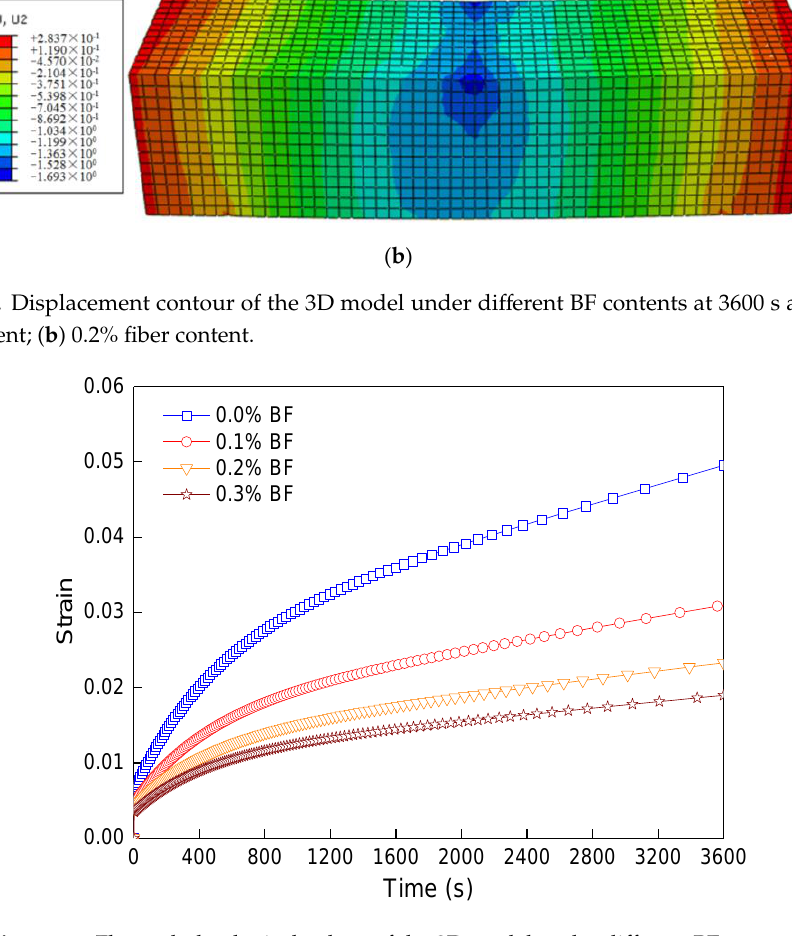
Figure 13. Flexural–rheological values of the 3D model under different BF contents.